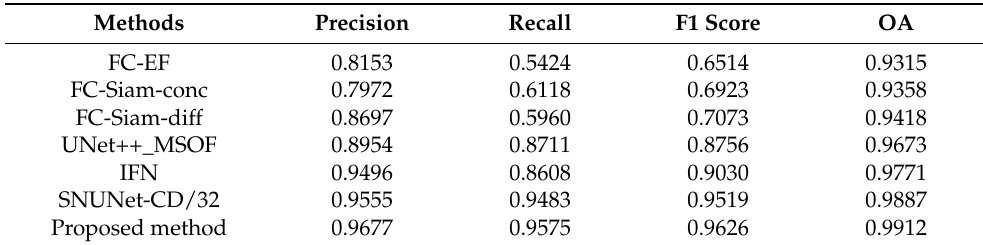
Table 3. Quantitative evaluation results of different